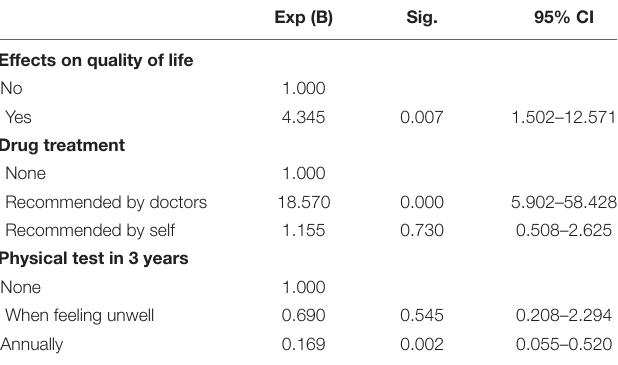
TABLE 3 | Factors associated with perceptions of drug